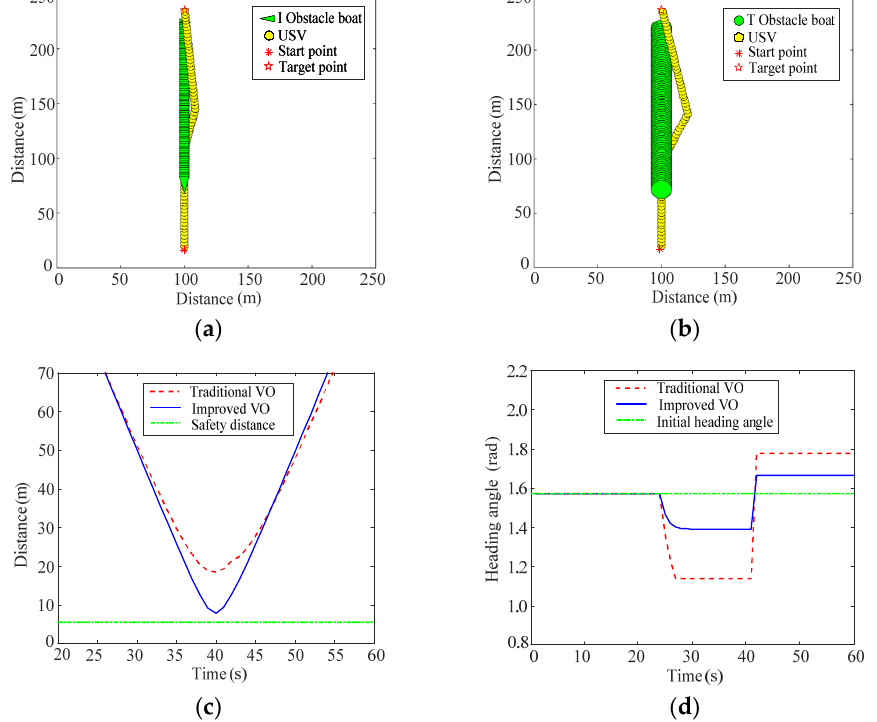
Figure 8. Simulation comparison of the head-on scene: ( a ) improved VO path simulation; ( b ) traditional VO path simulation; ( c ) relative distance comparison graph; ( d ) USV heading angle comparison